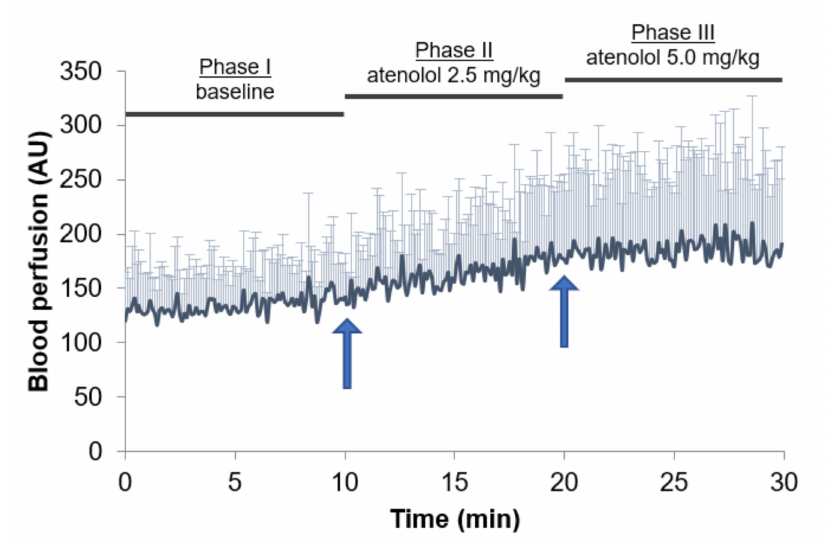
Figure 1. Mean + standard deviation (sd) of the local blood perfusion throughout the protocol (N = 6). The arrows mark the moments of the sequential administration of two atenolol dosages (2.5 mg / kg and 5.0 mg / kg) (see text). Table 1. Mean, standard deviation (sd) and percent variation ( ∆ ) of the blood perfusion (N = 6, mean for both hindlimbs, AU—arbitrary units) in the three phases of the protocol (Phase